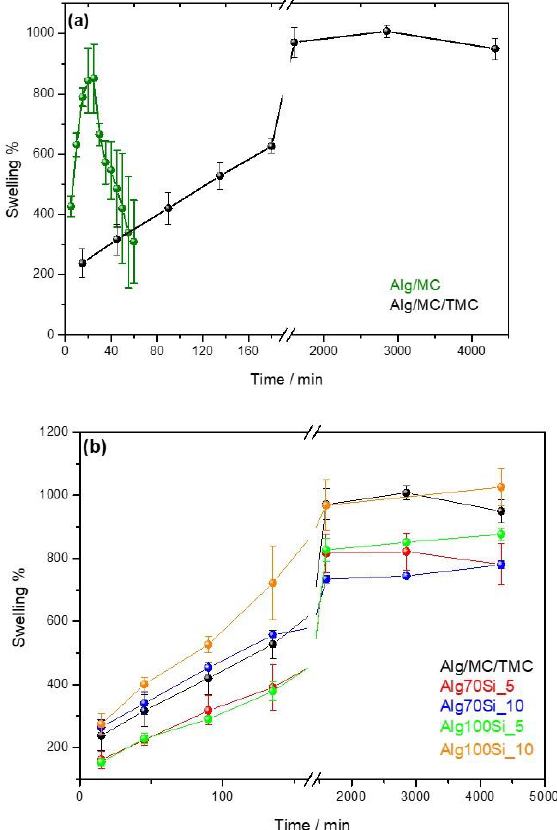
Figure 4. Swelling behavior of pure polysaccharide scaffolds ( a ) and composite scaffolds together with the sample containing TMC for comparison ( b ).